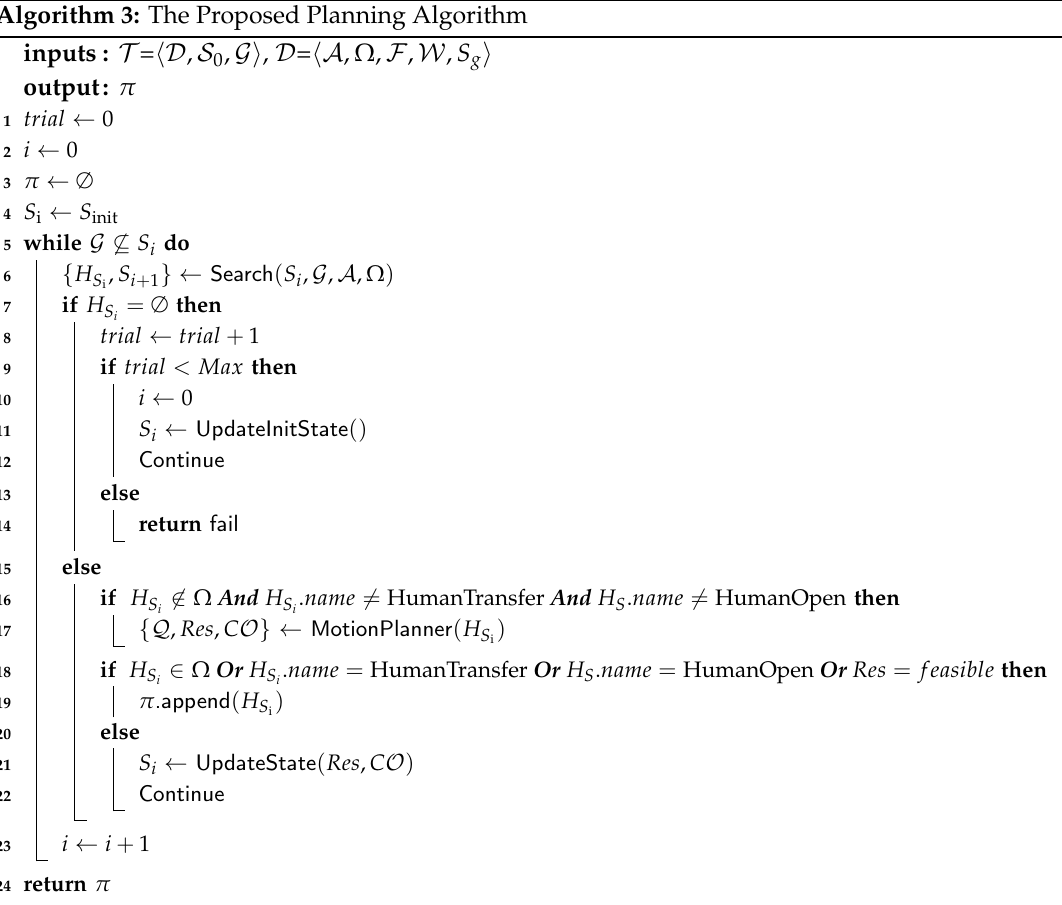
Algorithm 3: The Proposed Planning